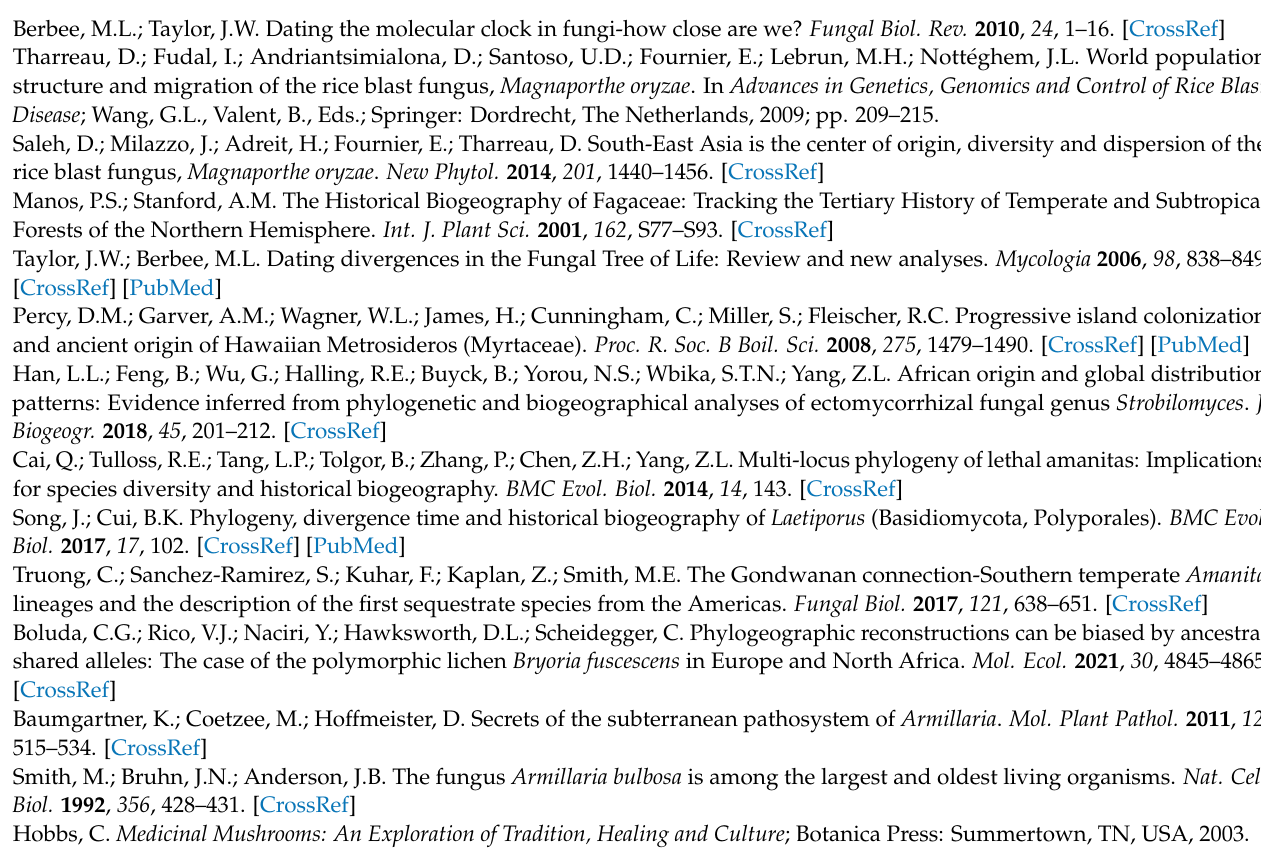
Table S1: Detailed information of 358 Armillaria and Desarmillaria samples used in this study, Table S2: Species and their sequences accession number used for molecular clock